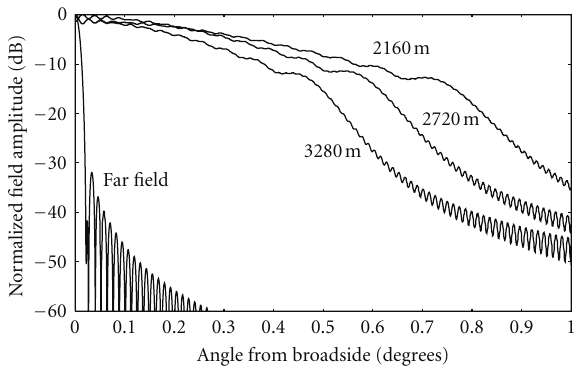
Figure 2: Simulated amplitude pattern at 22GHz of Sardinia Radio Telescope (64 m diameter parabolic reflector) for di ff erent distances.